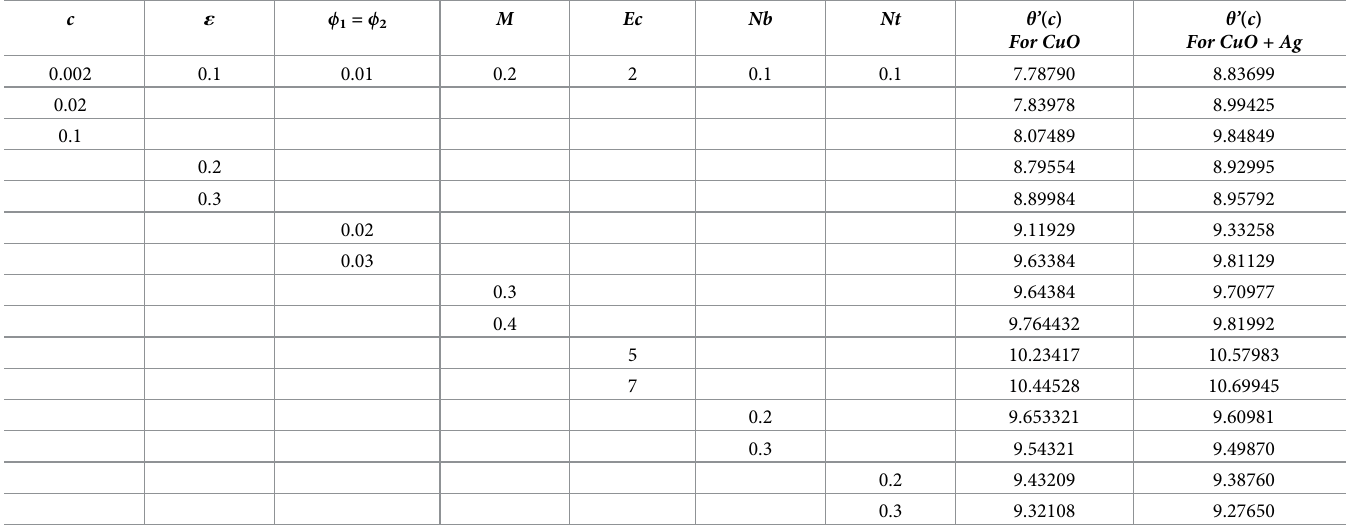
Table 5. Impact of different parameters on heat transfer coefficient θ’ ( c ).